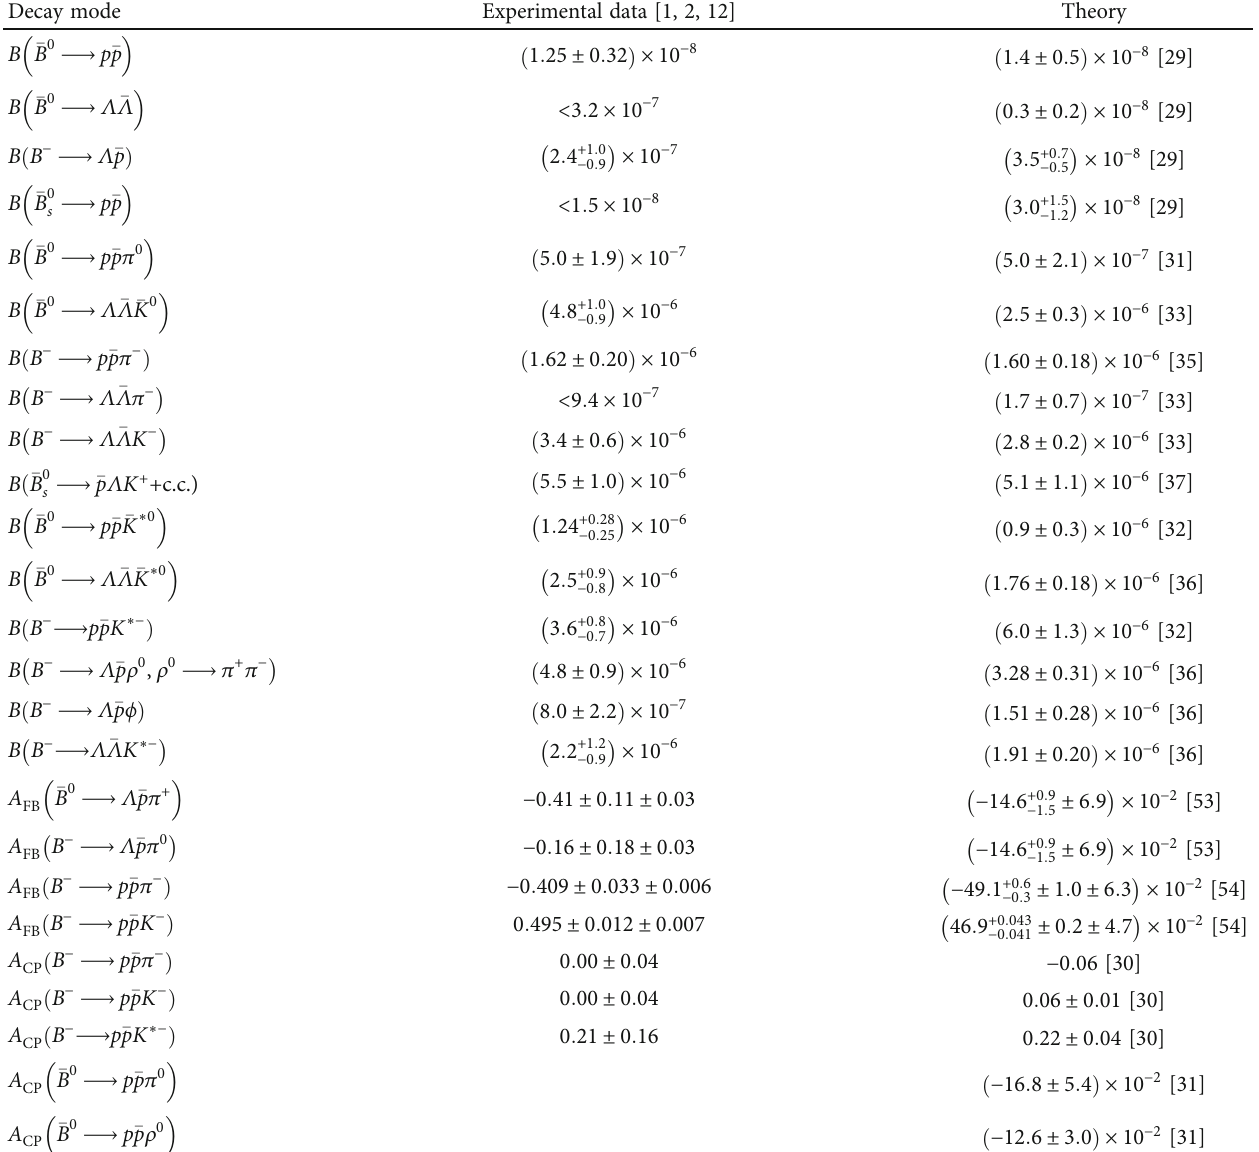
Table 2: Theoretical results of the two- and three-body baryonic B decays, in comparison with the experimental data. Decay mode Experimental data [1, 2, 12]